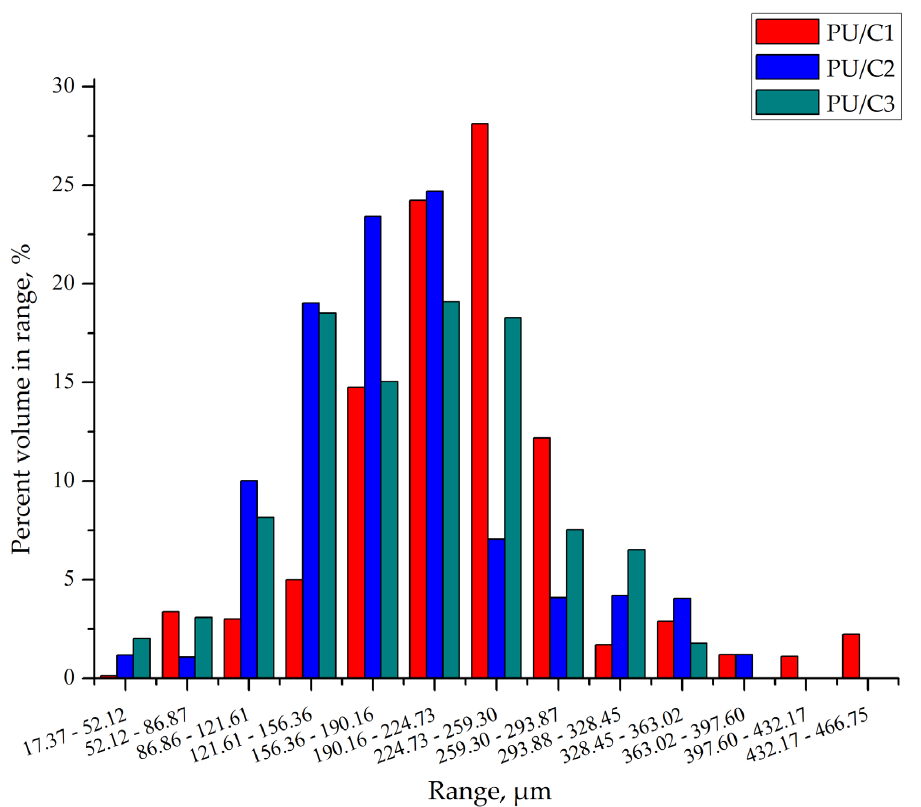
Figure 9. Particle size distribution in composites with 1 php cellulose (PU/C1), 2 php cellulose (PU/C2), and 3 php cellulose (PU/C3). Table 5. Total porosity, apparent density, and thermal conductivity of